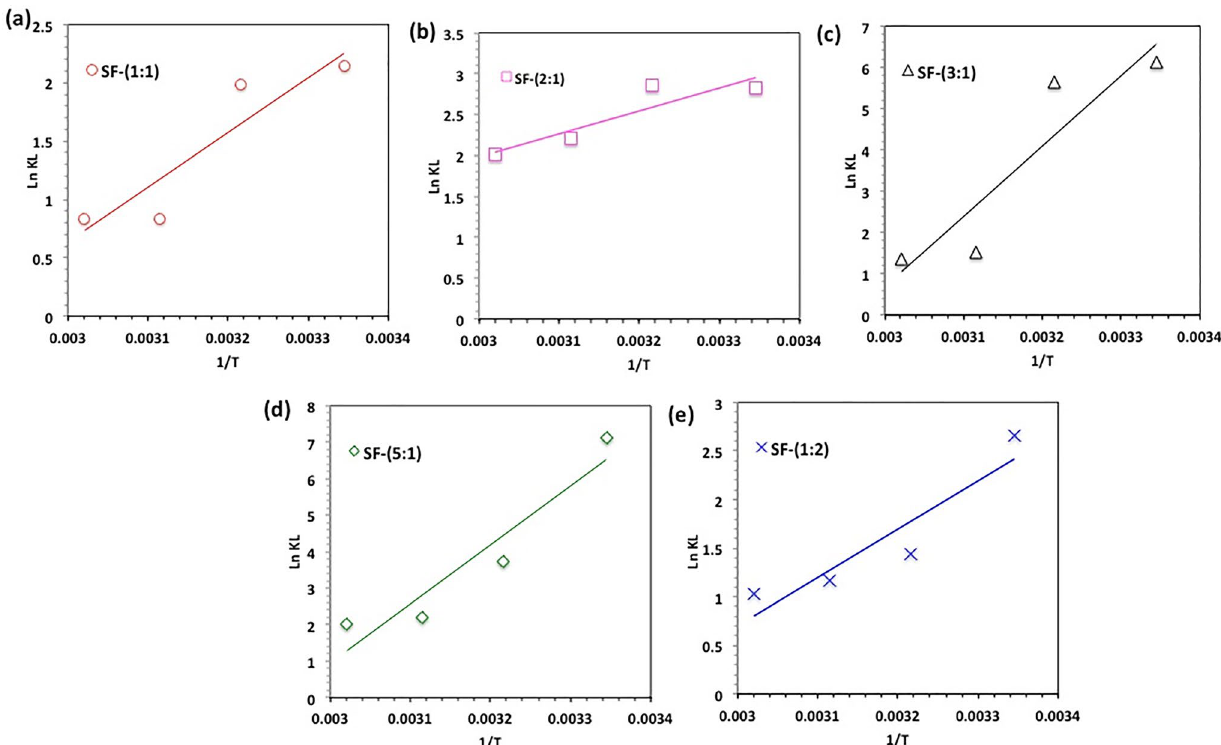
Fig. 10 Van’t Hoff plot of ln K